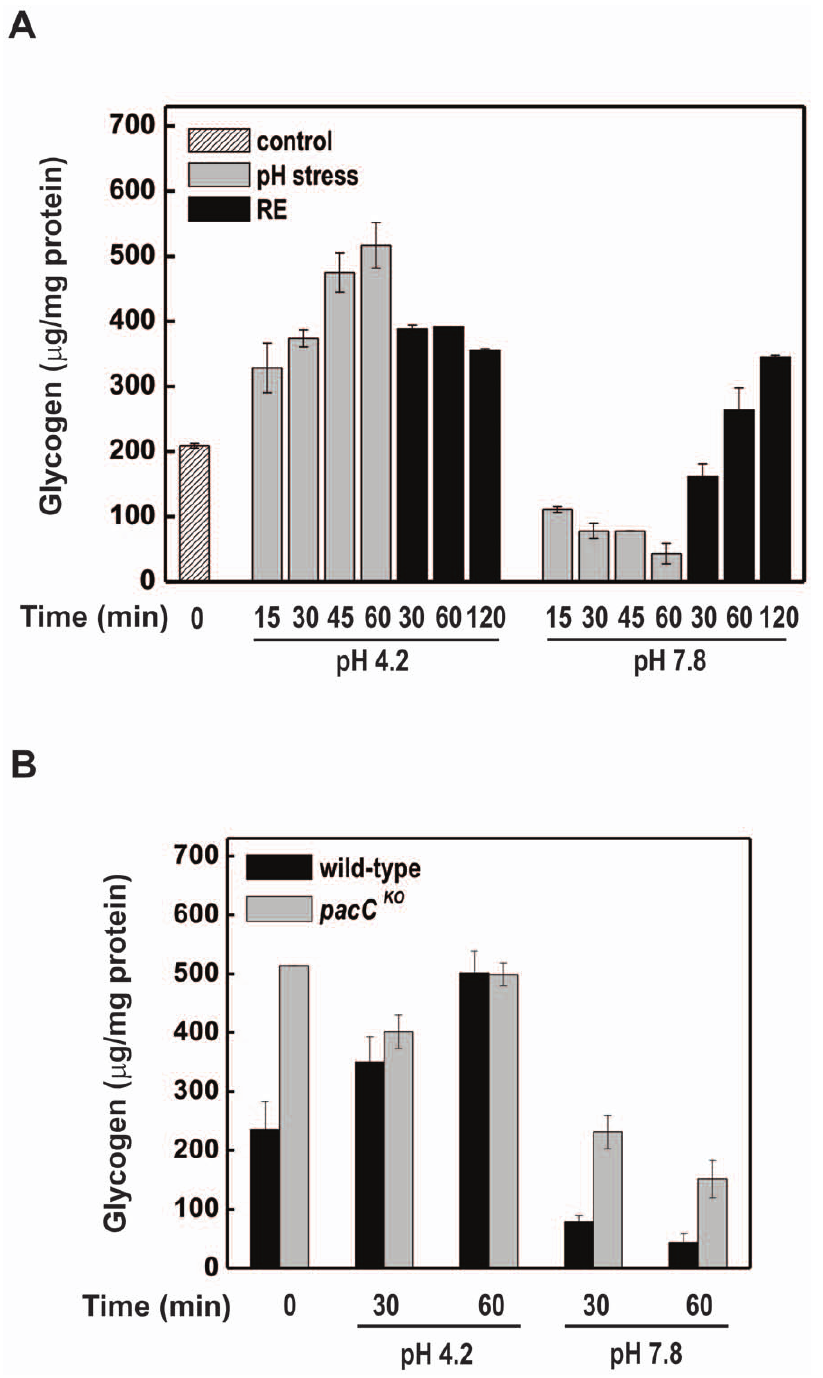
Figure 3. Glycogen accumulation during acid and alkaline pH stress. (A) Glycogen content in the wild-type strain. Glycogen was extracted from mycelia grown under physiological conditions (pH 5.8, control) and under acid (pH 4.2) and alkaline (pH 7.8) stress. After 120 min, the remaining cultures were transferred back to physiological conditions (pH 5.8, RE, recuperation). The results shown are the average of at least three independent experiments. (B) Glycogen content in the pacC KO strain compared to the wild-type strain. 0, cell samples before the pH shift (control). doi:10.1371/journal.pone.0044258.g003 analyzed (Figure 7A, lanes 4–6, 10 and 11). The binding from pacC KO strain were also assayed for binding reactions and reaction was apparently stronger when cellular extract prepared no DNA-protein complex was observed. The Figure 7A (lanes from cells grown at alkaline pH was used as a protein source 13–16) shows the results with one chromatographic fraction since the DNA-protein complex was shifted only at higher oligo from each pH and the competition with the oligo pacC . This pacC concentrations (20- and 30-fold molar excess). Fractions result indicated the existence of an active PACC protein in the